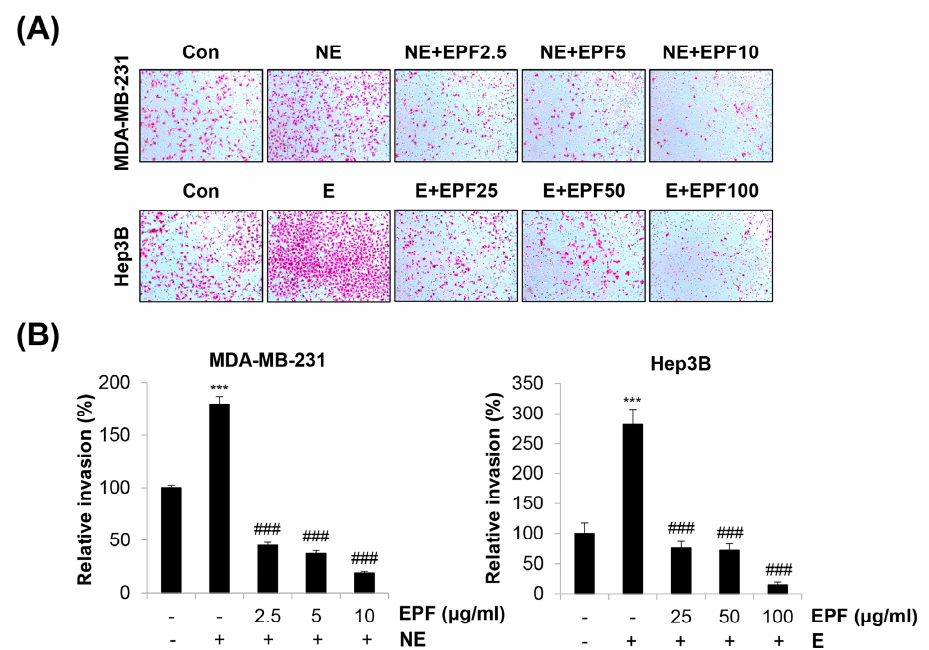
Figure 6. EPF suppresses E/NE-induced invasion of cancer cells. MDA-MB-231 human breast cancer cells (upper panel) and Hep3B human hepatocellular carcinoma cells (lower panel) suspended in serum-free media were seeded into Matrigel-coated inserts of 24-well Transwell plates and treated with either NE (1 µ M) or E (10 µ M) for 24 h in the presence of EPF at diverse concentrations (2.5-10 µ g/mL for MDA-MB-231; 25-100 µ g/mL for Hep3B). Medium containing 10% serum was added to the bottom chambers. After 24 h of incubation, invaded cells were stained and photographed ( × 100 magnification). Representative images from triplicate analyses are shown ( A ). Relative invasion compared to that of untreated control cells was evaluated by counting stained cells ( B ). The data are expressed as the mean ± SD of three independent experiments. Significance was determined by the Student’s t -test (*** p < 0.001 vs. untreated controls; ### p < 0.001 vs. E/NE-treated cells). E, epinephrine; NE, norepinephrine; EPF, ethanol extract of Perilla frutescens